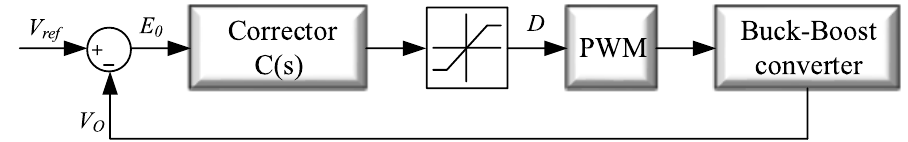
Figure 10. Block diagram of the regulation for the output voltage for the buck-boost